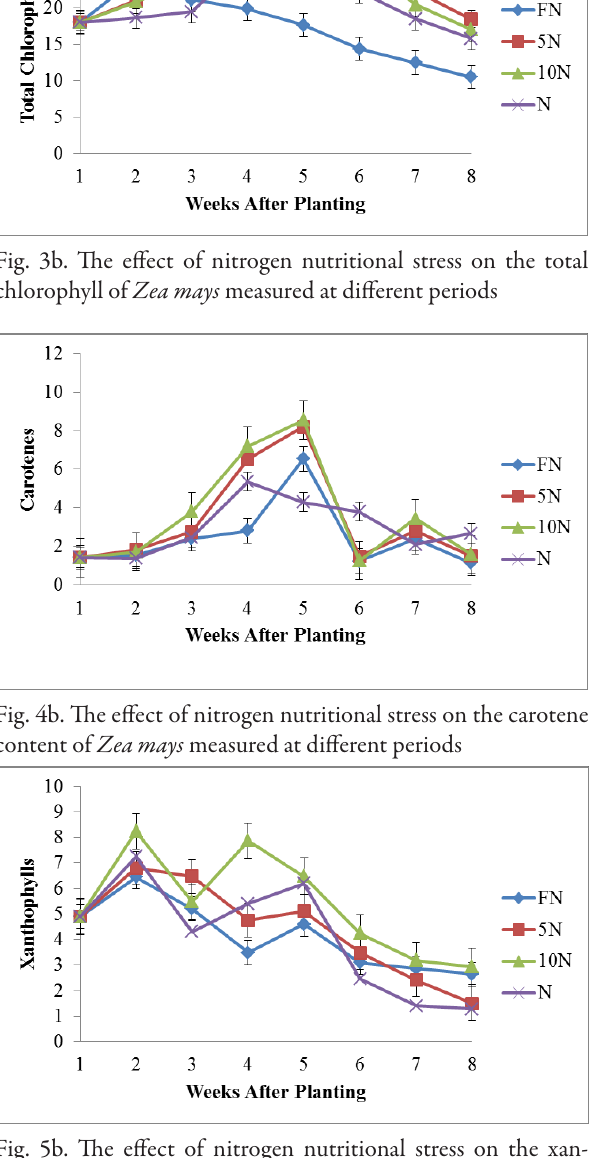
Fig. 5b. The effect of nitrogen nutritional stress on the xan- thophyll contents of Zea mays measured at different